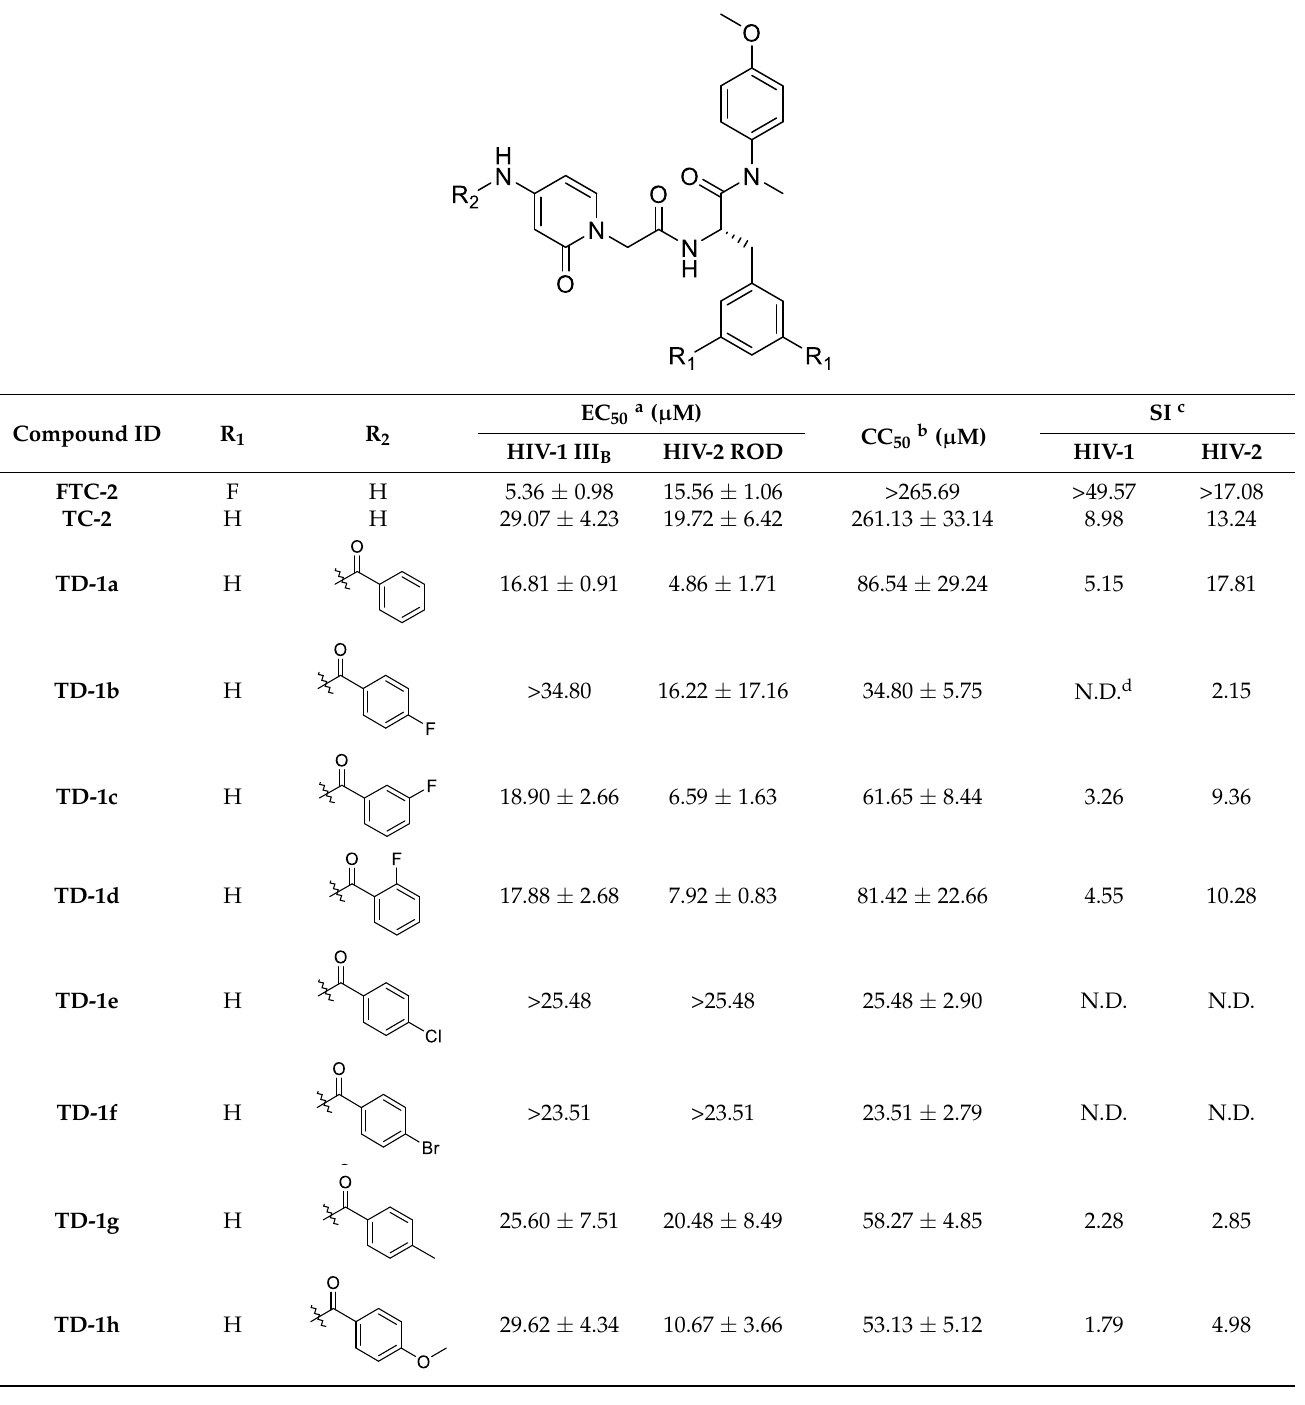
Molecules 2022 , 27 , x FOR PEER Table 1. Anti-HIV Activity and Cytotoxicity in MT-4 Cells Infected with HIV-1 III B and HIV-2 ROD.